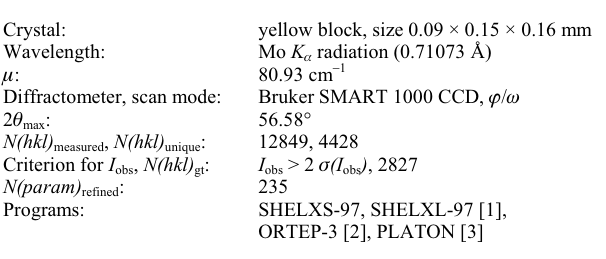
Table 1. Data collection and handling.